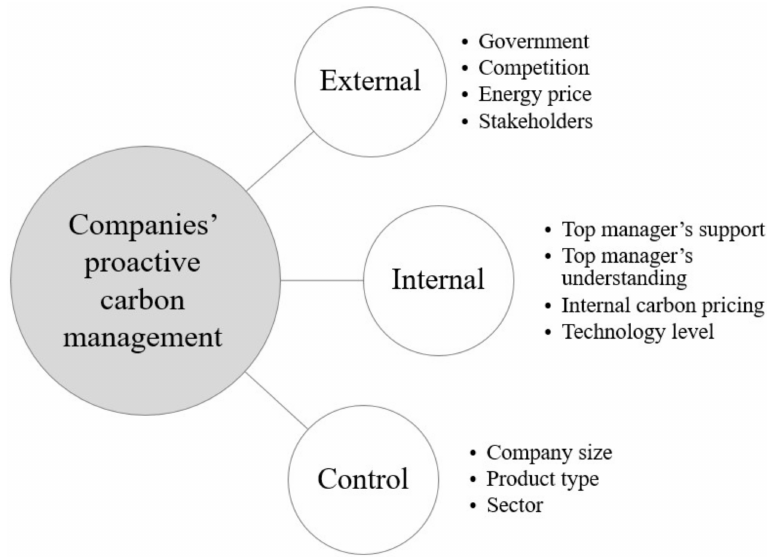
Figure 1. Analytical framework for determinant factor of companies’ proactive carbon